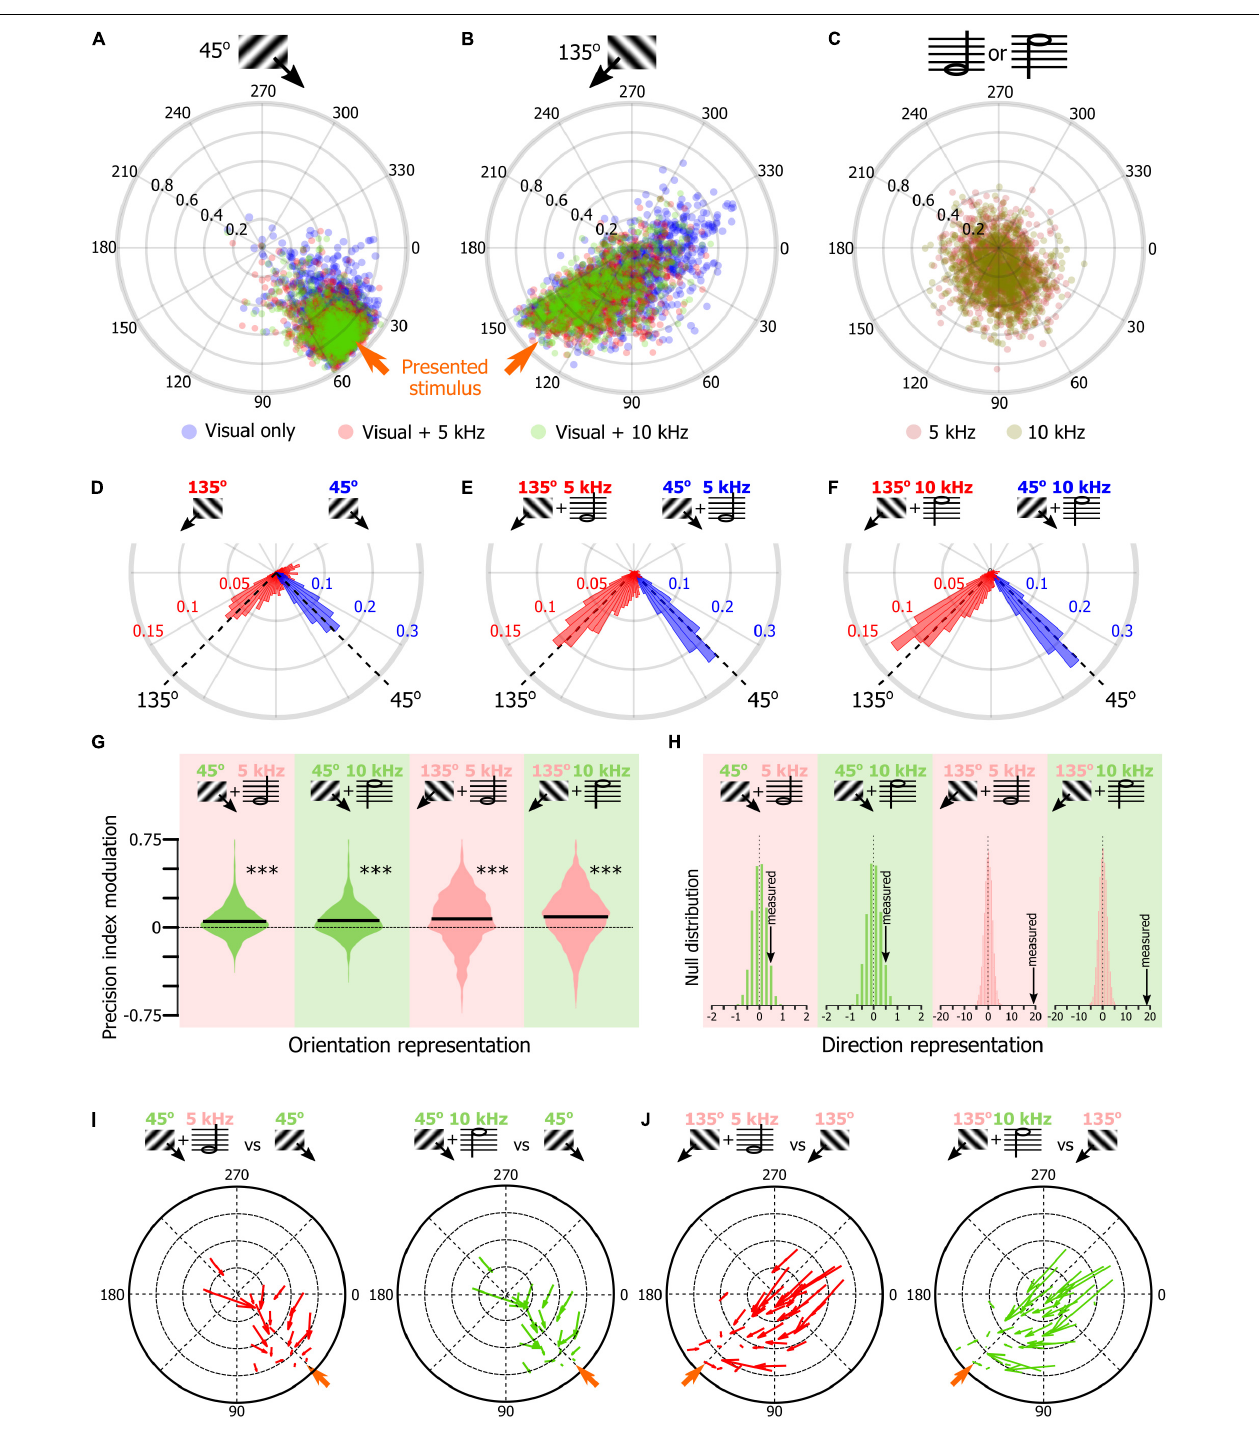
FIGURE 4 | Sound modulation of the V1 population evoked response in naïve mice. (A) Output of 1,000 SNNs made of 250 randomly selected V1 neurons to the presentation of a 45 ◦ drifting grating in the unimodal (blue) and audiovisual (5 kHz tone: red; 10 kHz: green) contexts. The orange arrow indicates the orientation of the presented stimulus. (B) Same representation as in panel (A) for the presentation of the 135 ◦ drifting grating. (C) Same representation as in panel (A) for the presentation of unimodal auditory stimuli (5 kHz tone, dark red; 10 kHz, dark green). (D) Distribution of the orientations indicated by the output circular mean of the 1,000 SNNs shown in panels (A,B) when the input is the neuronal activity evoked by the unimodal 45 ◦ (blue) and unimodal 135 ◦ (red) drifting grating. (E) Same representation as in panel (D) when the visual stimulus is paired with the 5 kHz tone. (F) Same representation as in panel (D) when the visual stimulus is paired with the 10 kHz tone. (G) Modulation by the 5 kHz (red background) and 10 kHz (green background) sounds of the precision indexes of the 1,000 SNN shown in panels (A,B) . The black bar indicates the mean of the distribution. ∗∗∗ Random permutation test ( p < 0.0001). (H) Comparison of the percent of SNN outputs shown